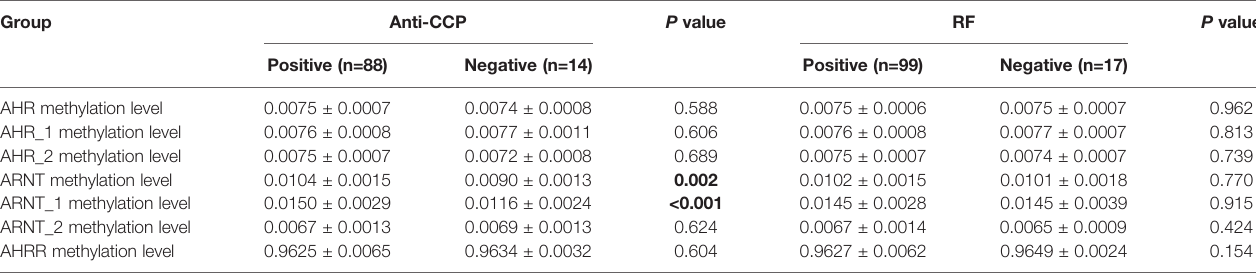
TABLE 6 | Relationship between AHR, ARNT, AHRR methylation levels and anti-CCP, RF in RA patients. Group